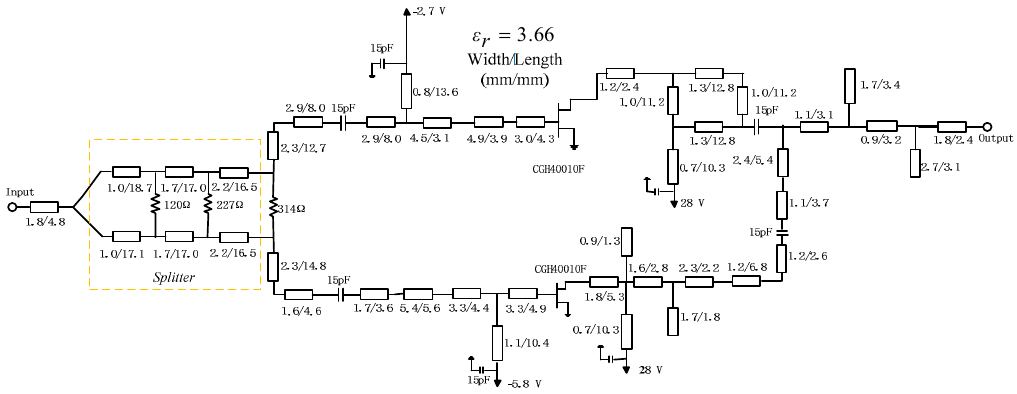
Figure 13. Completed DPA circuit with distributed parameters.